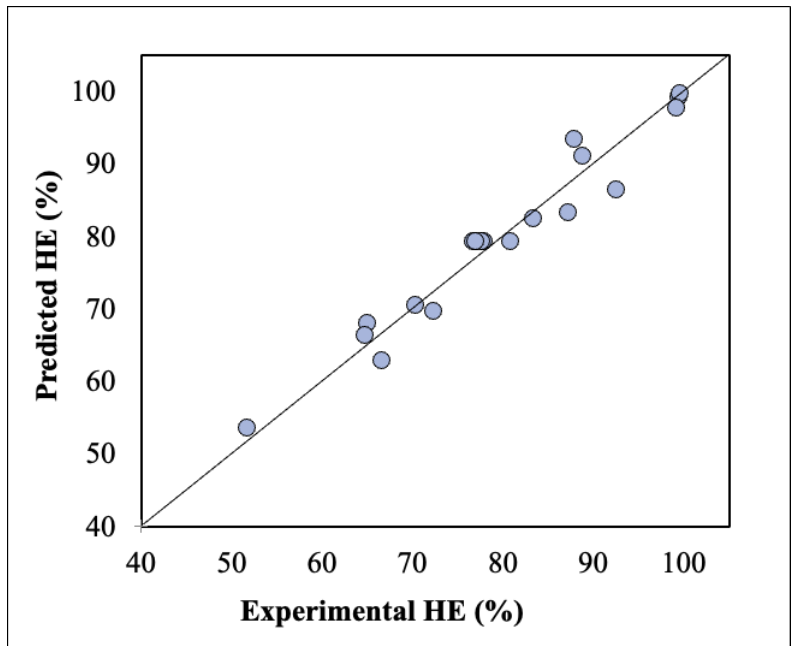
Figure 4. Predicted versus experimental values of harvesting efficiency.